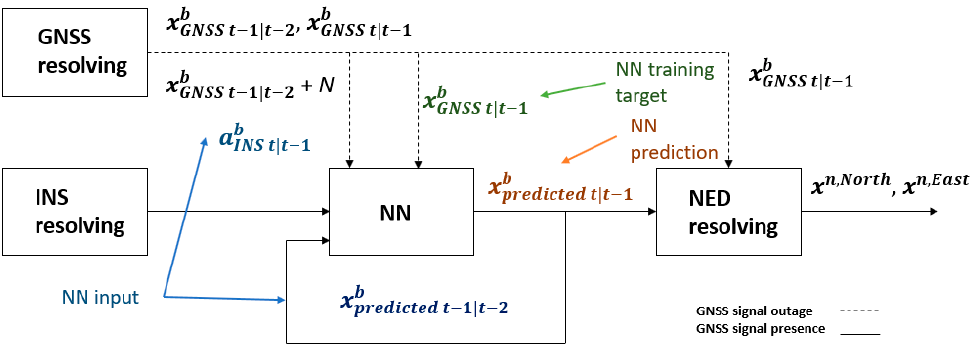
Figure 2. Prediction set-up of the proposed displacement estimation model.